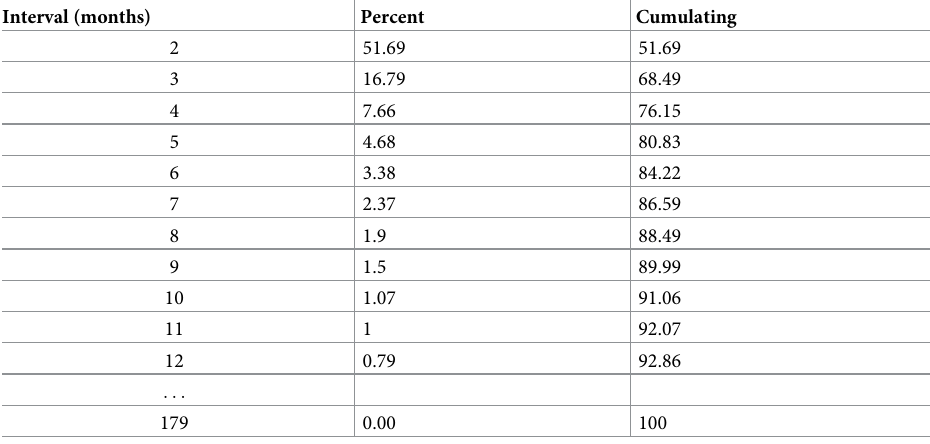
Table 2. Intervals between two trade spells (Source: Authors’ calculation).